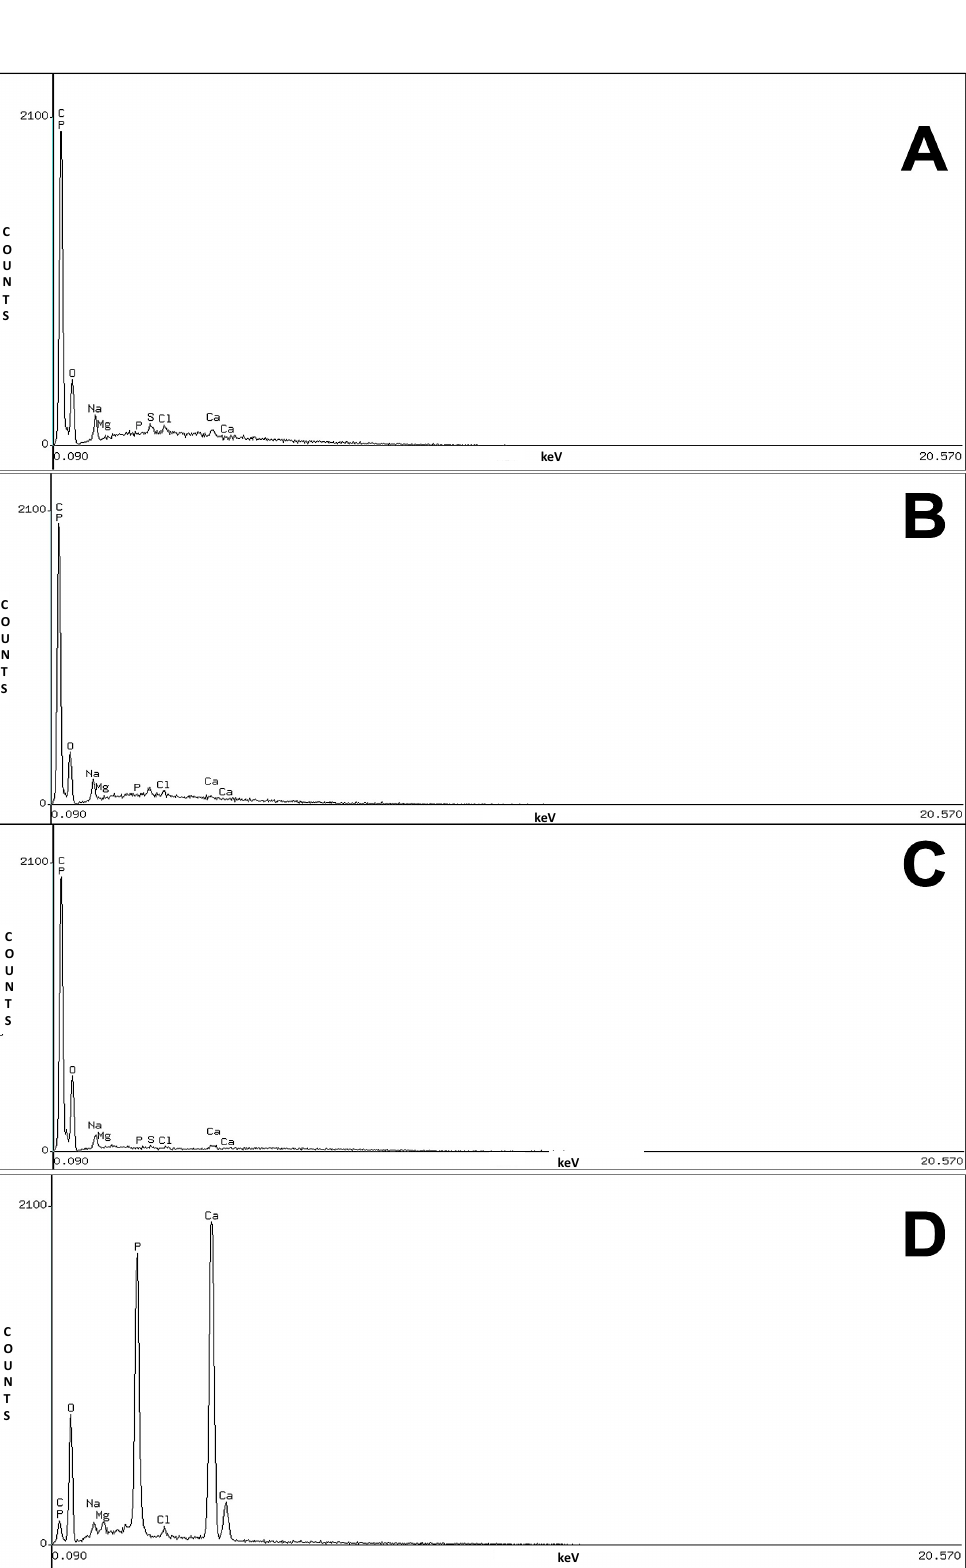
Figure 4. Chemical analysis by EDS indicated that the scaffolds did not contain calcium or phosphorus and therefore were demineralized. In contrast, mineralized bovine bone had a high calcium and phosphorus content. The 0.125 M ( A ), 0.25 M ( B ), 0.5 M scaffolds ( C ), and ( D ) bovine bone.